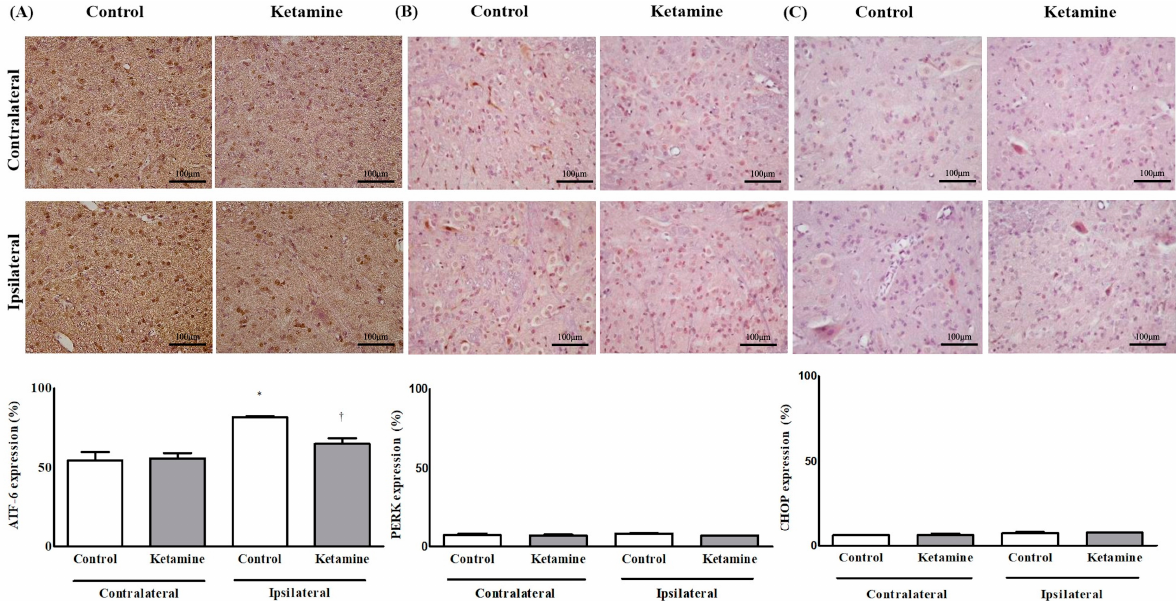
Figure 4. The immunohistochemistry assay for the expression of endoplasmic reticulum stress in the spinal cord. ( A ) Activating transcription factor-6 (ATF-6), ( B ) Protein kinase R-like endoplasmic reticulum (PERK), and ( C ) CCAAT-enhancer-binding protein homologous proteins (CHOP). Abbreviations: contralateral, contralateral side for surgery; ipsilateral, ipsilateral side for the surgery; control, control group; ketamine, ketamine group. * p < 0.05 compared with the contralateral side in each group. † p < 0.05 compared with the control group.